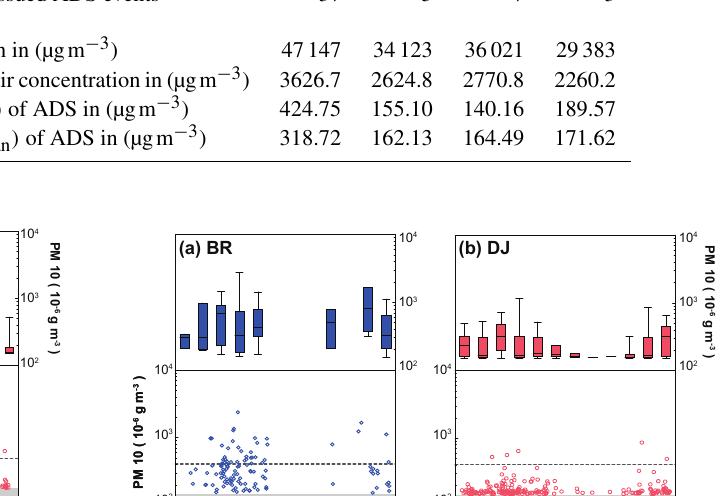
Table 2. Summary of ADS discharge from January 2003 to August 2015. Number of days ( n ADS ) with advisory warning issued ADS events 111 220 257 155 Number of days ( n ADS ) with danger warning issued ADS events